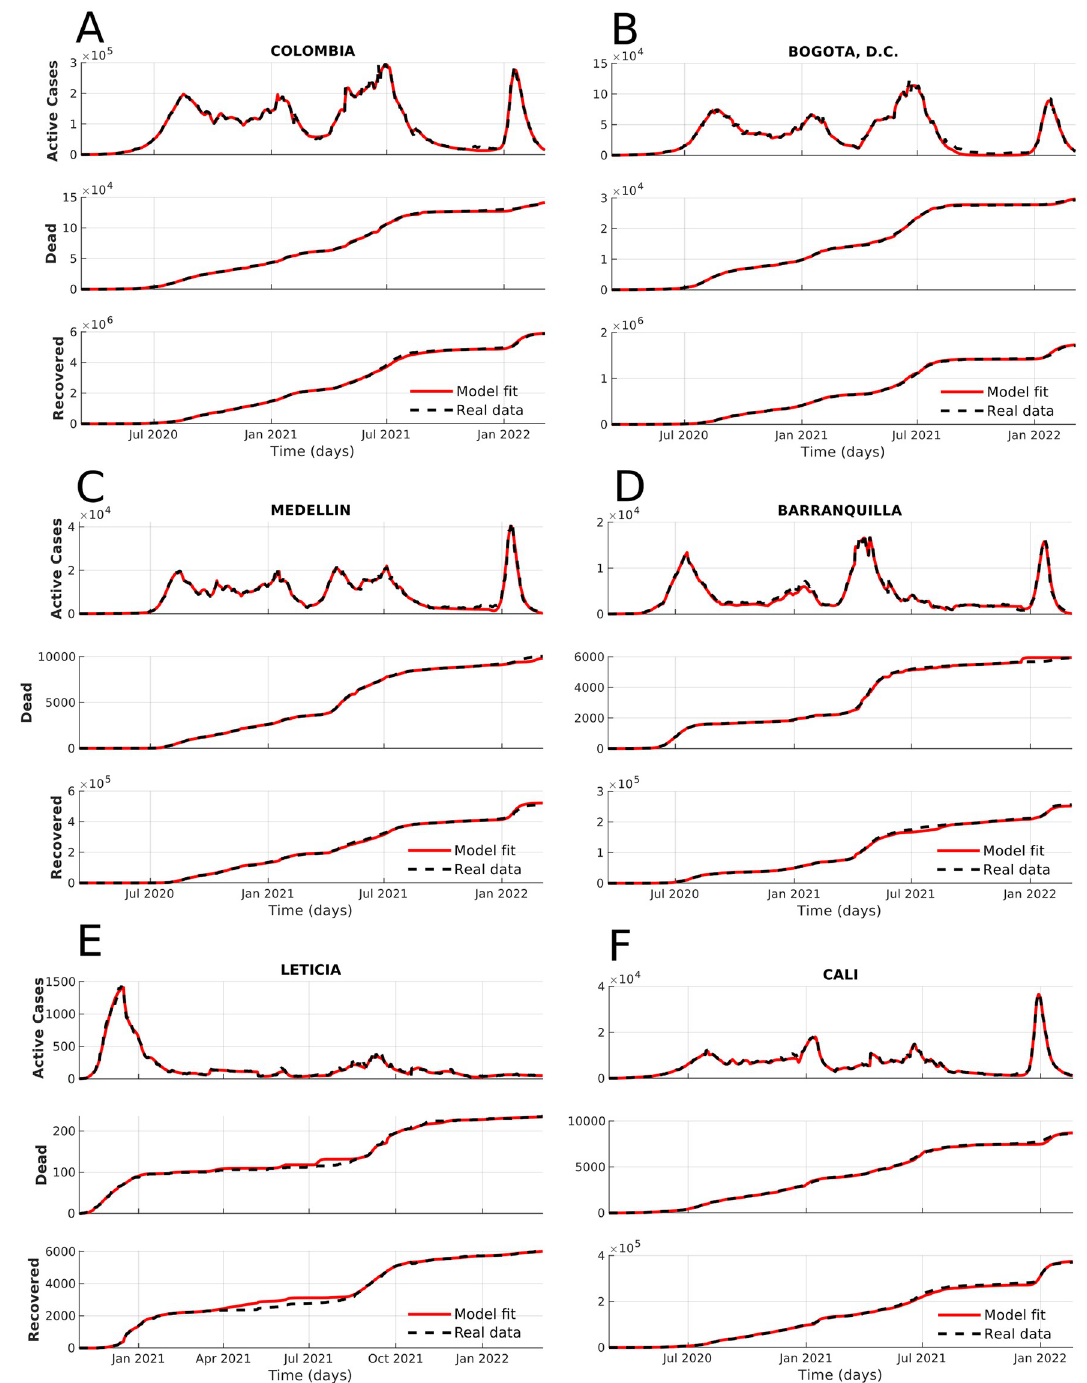
Fig 5. Model fitting for actual, dead, and recovered cases from march 2020 to February 2022. Note that the active cases correspond to the actively infected individuals at a specific moment.